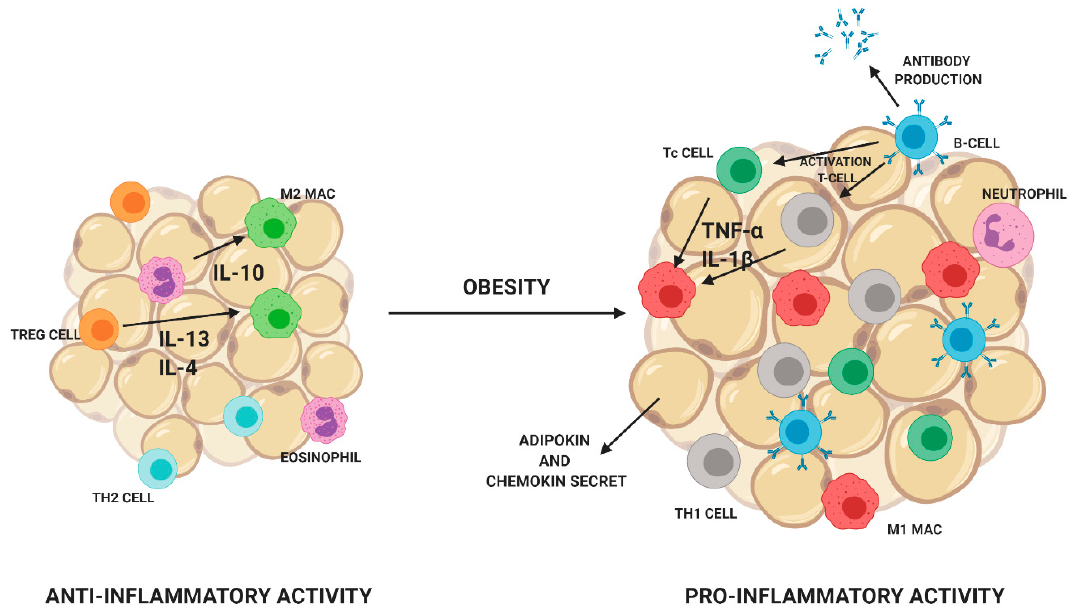
Figure 4. Inflammatory processes in the fat tissue. In obese people, the composition and number of cells in the immune system change. Reduction in the number of Treg lymphocytes, eosinophilia, and M2 macrophages and an increase in the number of B, Th1 lymphocytes, neutrophils, and M1 macrophages. Created with